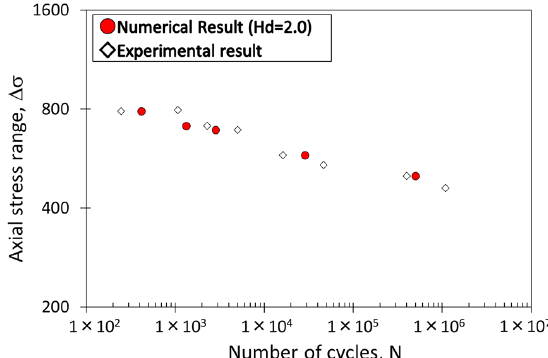
Figure 13. Relationship between cumulative damage plastic strain, H d , and number of cycles under constant amplitude loading.